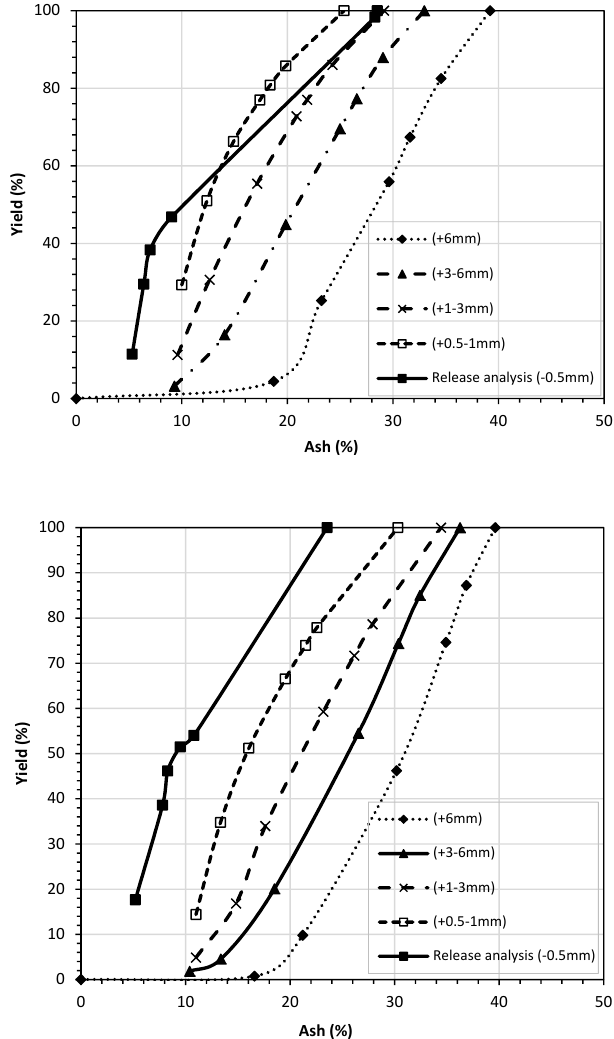
Fig. 5. Diagram of the sink-float analysis of the industrial cage mill and the laboratory jaw